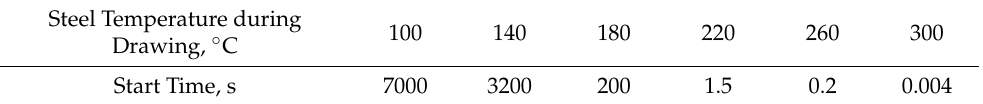
Table 4. Start time of static strain